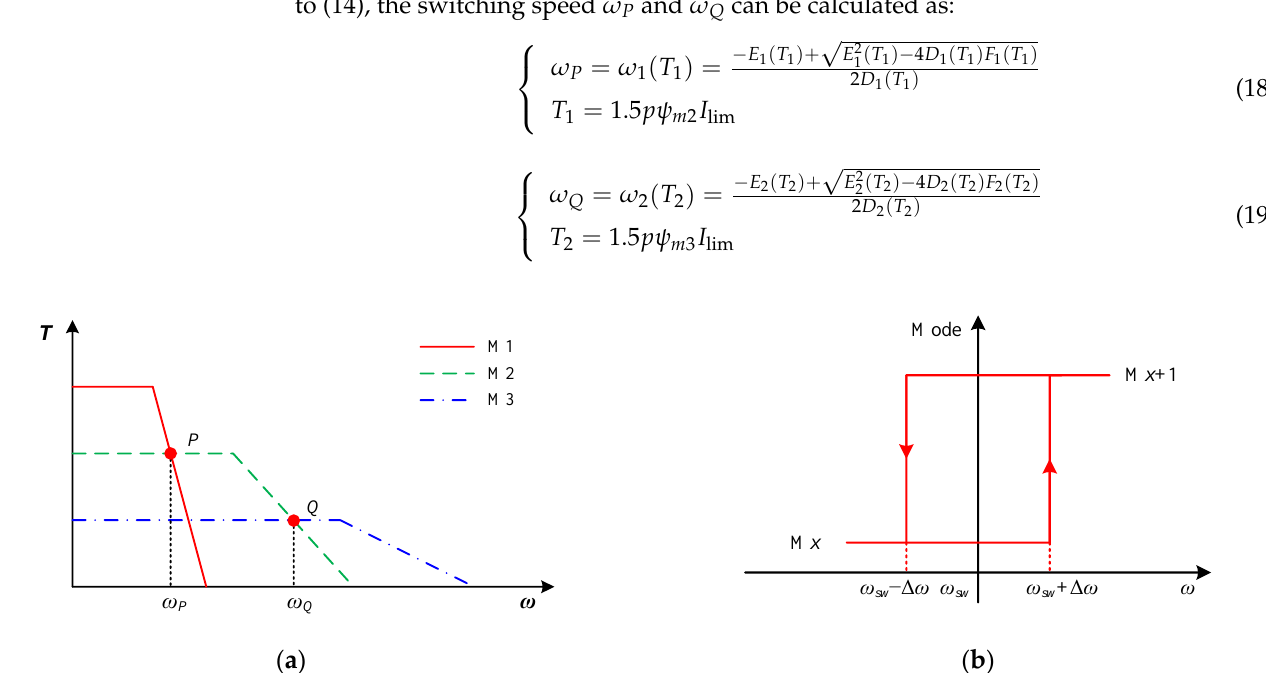
Figure 5. Principle of the speed-based WS strategy. ( a ) Torque – speed curves of three operating modes. ( b ) The hysteresis controller.